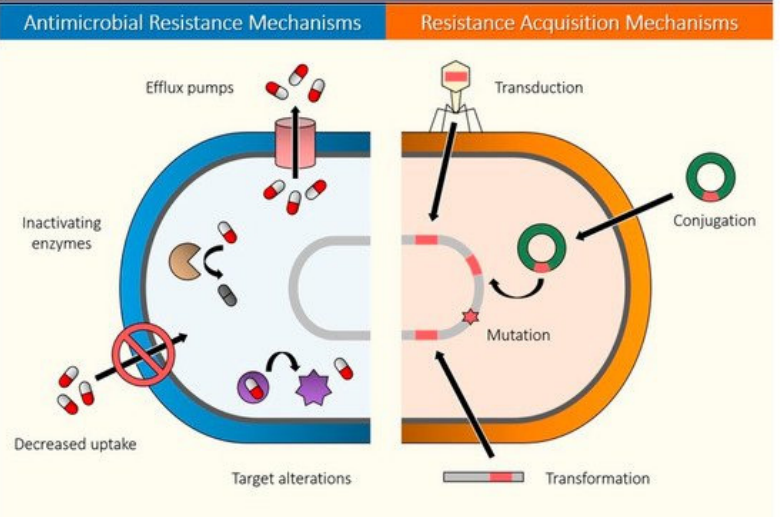
Figure 3. Mechanism of antibiotic resistance in antibiotic-resistant bacteria. Antibiotic-resistant bacteria may neutralize antibiotics via different mechanisms such as inactivating enzymes, altering their permeability to reduce antibiotics taken into the cell, eliminating antibiotics that enter the cell using efflux pumps, decreasing uptake of antibiotics, and modifying the targets of the antibiotics. Bacteria may acquire these resistance mechanisms via transduction, conjugation, mutation, and transformation. Reprinted from Á lvarez-Mart í nez et al. [61] under the open access Creative Common CC BY license of